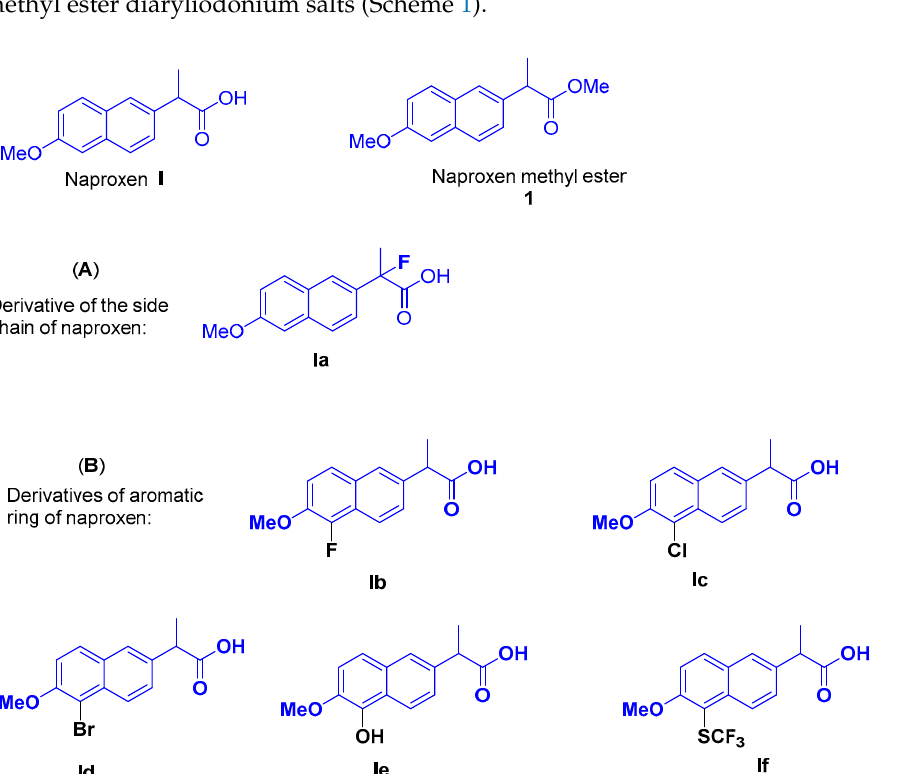
Figure 1. The structure of Naproxen and its typical derivatives: ( A ) the introduction of fluorine atom into the side chain; ( B ) the functionalization of the aromatic ring of naproxen.